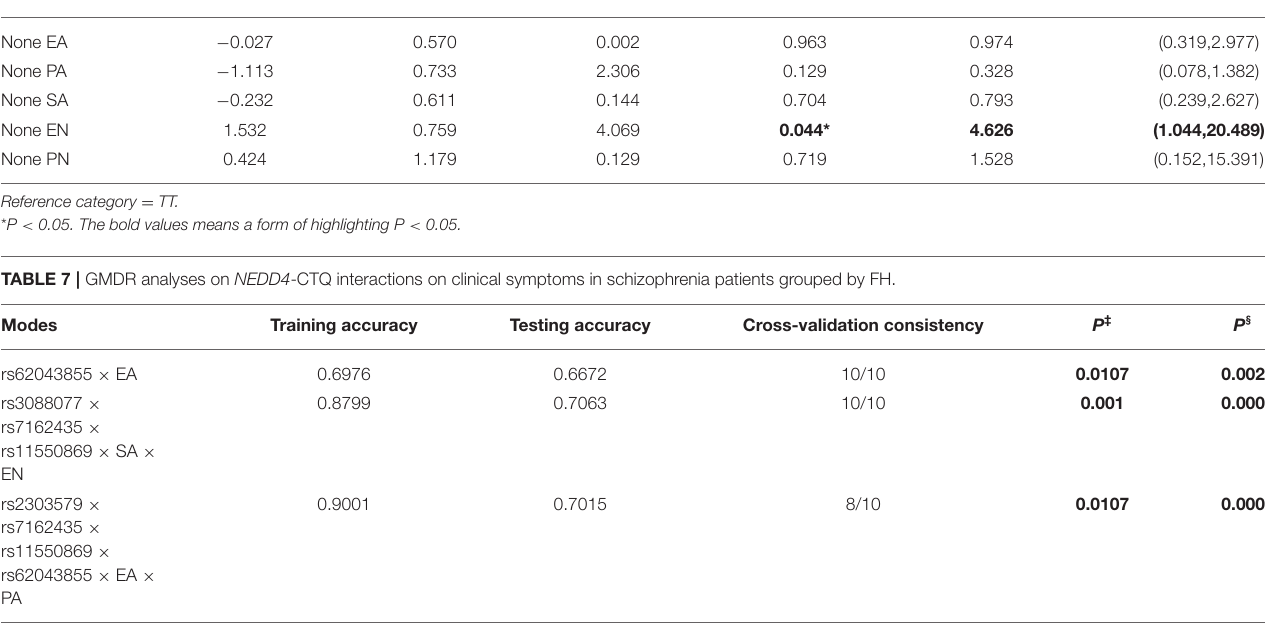
TABLE 6 | Interaction between rs3088077 and CTQ by Logistic regression. Variables